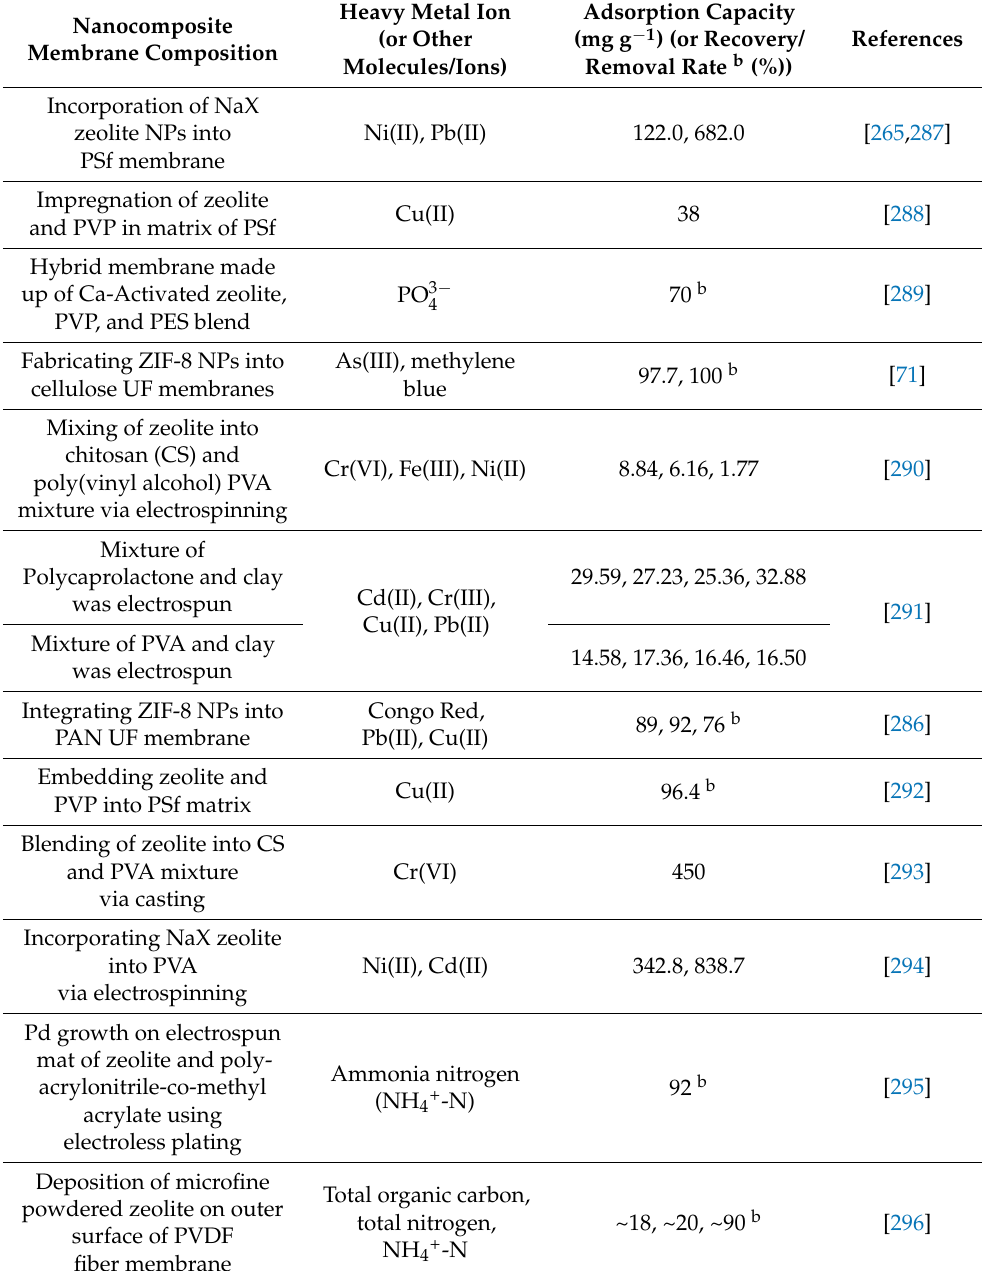
Table 6. An overview of nanocomposite membranes for the effective removal of especially heavy metal ions and few inorganic ions and